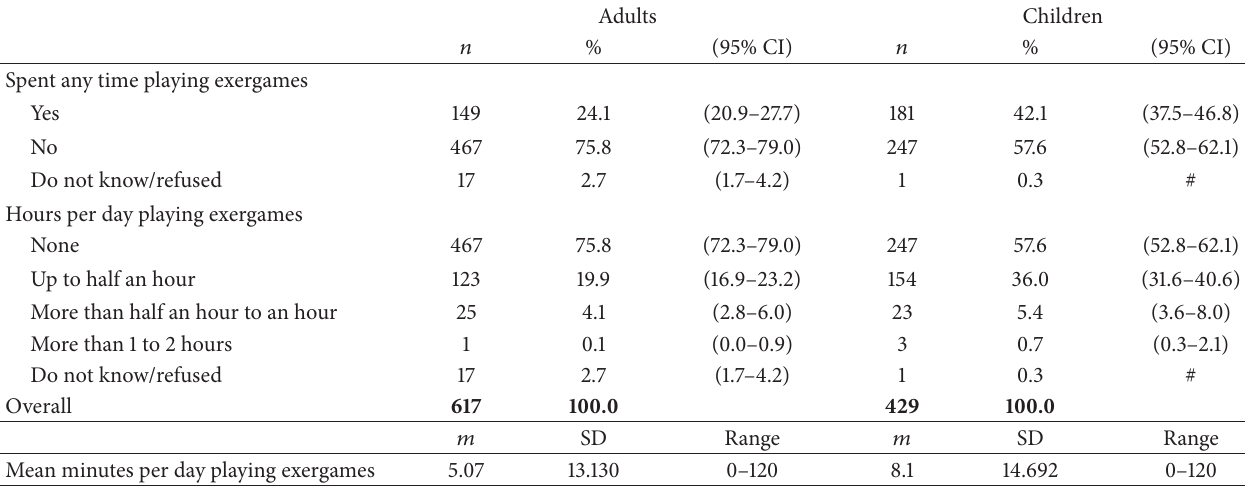
Table 4: Time spent playing exergames, for adults and children who reported playing video